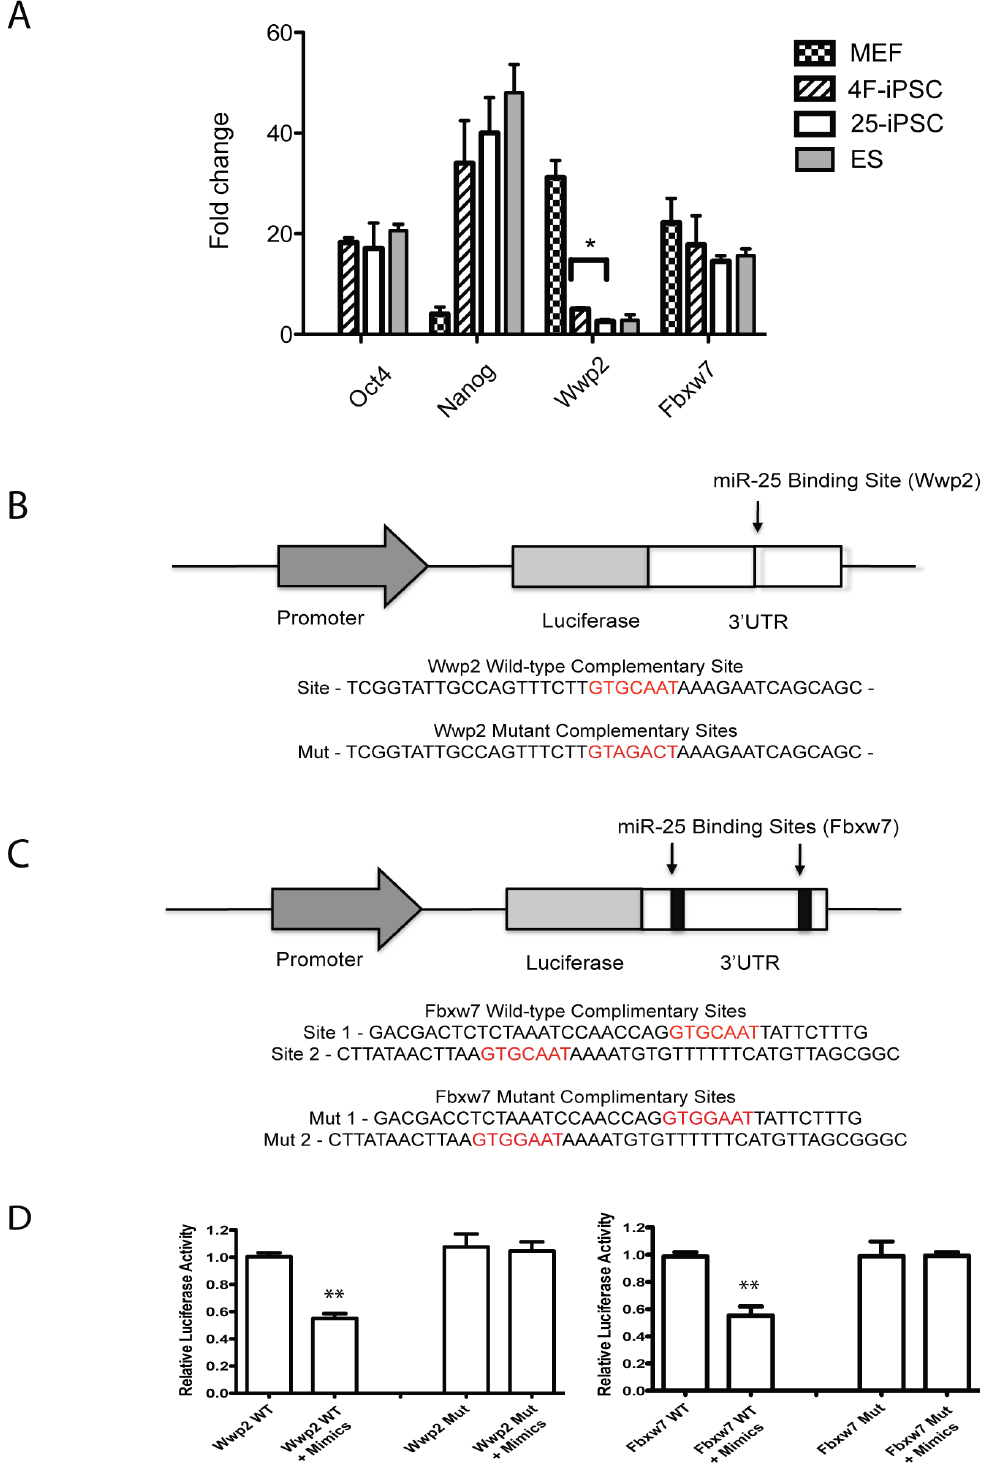
Figure 6. Validation of miR-25 targets. a. Realtime RT-PCR analysis of expression of Oct4 , Nanog , Wwp2 and Fbxw7 in MEFs, iPSCs and ES cells. A significant decrease of Wwp2 was detected in 25-iPSCs, compared to 4F-iPSCs. Gene expression was normalized against Gadph . Error bar (mean 6 SEM. N=3 cell lines). * P , 0.05 compared with 25-iPS cells for Wwp2 expression. b–c. Luciferase reporter assay to the validate miR25 binding sites in the 3 9 UTRs of Wwp2 and Fbxw7 . Schematic diagrams of the reporters for Wwp2 ( b ) and Fbxw7 ( c ). The wild type and mutated miR-25 binding sites (highlighted in red) were indicated. The 3 9 UTR of Wwp2 has one miR-25 binding site, whereas Fbxw7 has two. The 3 9 UTR genomic regions amplified for both Wwp2 and Fbxw7 are about 1.6 kb. d. Luciferase reporter assays for validating Wwp2 and Fbxw7 as direct targets of miR-25. Wild-type (Wt) or Mutant (Mut) reporter plasmids were co-transfected with miR-25 mimic or a control mimic into HeLa S3 cells to assay for the miR-25 dependent repression of Wwp2 and Fbxw7 reporter. Data are presented as mean 6 SEM (N=3). Comparison between groups were performed using one-way ANOVA followed by the Newman-Keuls post test to determine statistical significance. ** P , 0.001. doi:10.1371/journal.pone.0040938.g006 PLOS ONE |